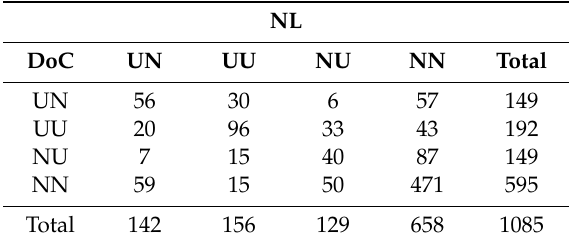
Table 2. Number of households for each combination of label use in 2013 and 2015.